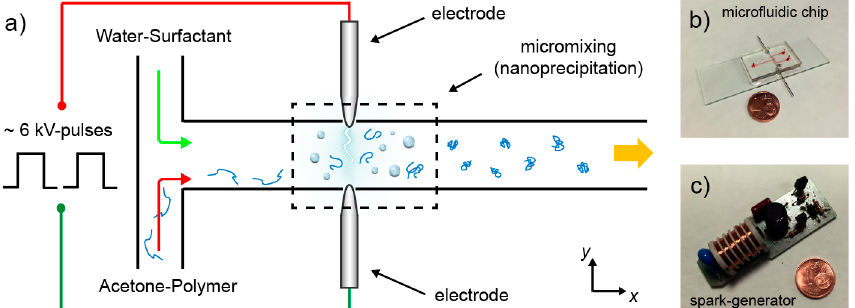
Figure 1. Operating principle and implementation of the cavitation-based PNPs generator. ( a ) Schematic representation of the micromixing-based nanoprecipitation device. The application of a train of high-voltage pulses between two tip electrodes forms plasma and hence cavitation bubbles. The bubble dynamics, i.e., growth and collapse, rapidly mixes the fluids causing precipitation of the polymers in forms of nanoparticles. ( b ) Optical image of the microfluidic chip filled with red-colored water for highlighting the T geometries. ( c ) Optical image of the spark